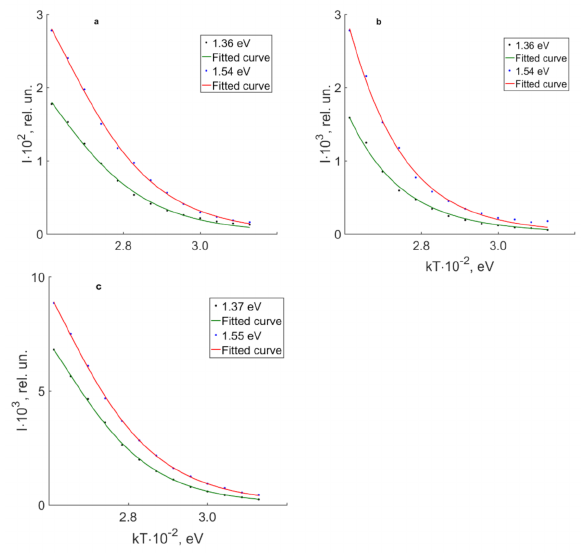
Figure 11. Curves of luminescence thermal quenching measured for 1.36 and 1.54 eV bands for crystals SLN ( a ), CLN ( b ), SLN (6.0 wt% K 2 O) ( c